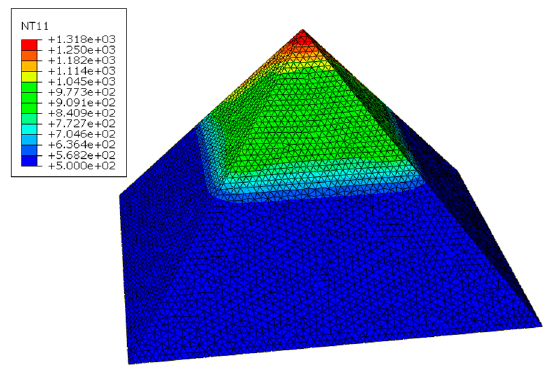
Figure 11. Temperature nephogram of samples with graphene after 1 s heat transfer.